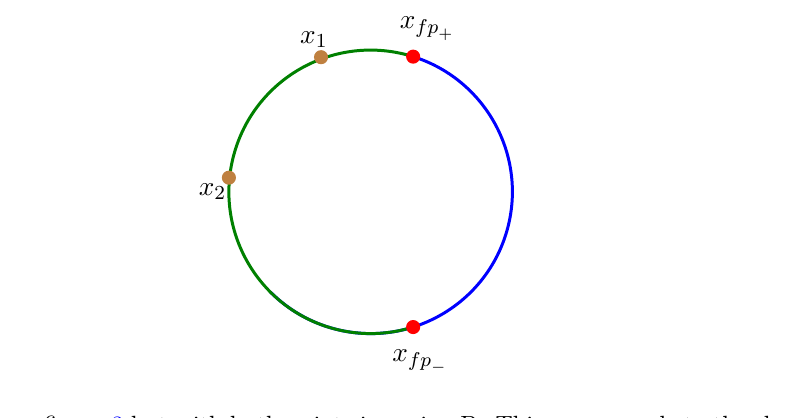
Figure 3 . Schematic representation of two regions marked in the region plot as A and B. The green part of the circle represents B while the blue part represents A. Fixed points on the circle are marked with two red dots. The brown dots label the positions of the two operators at x 1 and x 2 . For non trivial behaviour, both the operators have to be on the same side of the fixed points (figure 5). In this figure both points are in region A.